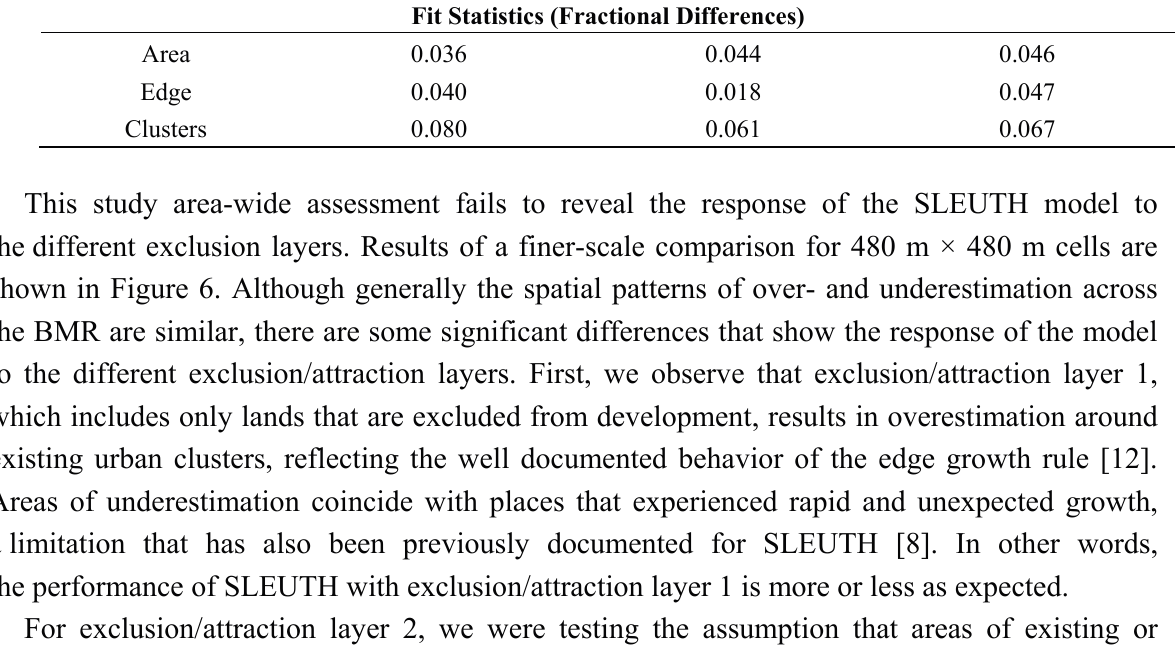
Table 1. Parameter values and fit statistics for the best performing calibration runs. Fit statistics are reported as fractional differences between simulated and observed values. Positive values indicate model-overestimation, negative values indicate model underestimation. Values closer to zero indicate higher fits. Parameter Values Exclusion/Attraction 1 Exclusion/Attraction 2 Exclusion/Attraction 3 Diffusion 1 1 1 Breed 1 1 25 Spread 25 20 Slope